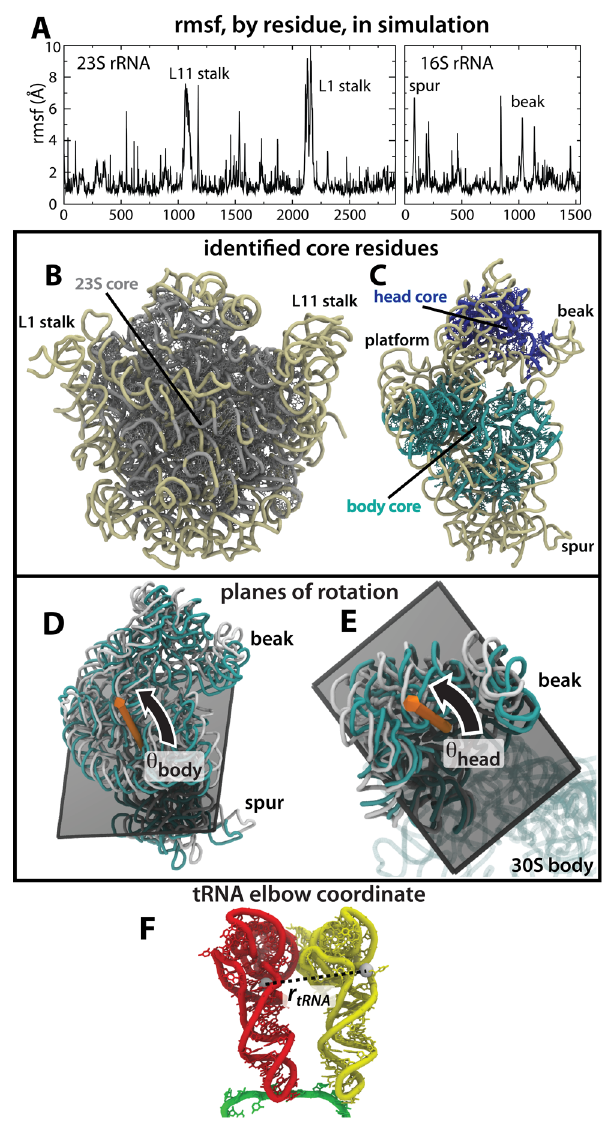
Figure 3. Reaction coordinates for 30S rotation and tRNA movement. A) rmsf, by residue, for the 23S (left) and 16S (right) rRNA. rmsf measures (See Text S1) were used to define the core residues (shown with side chains) of the: B) 23S rRNA (gray) and C) 16S body (cyan) and 16S head (blue). Core residue groups were used to define the planes of rotation for D) body rotation ( h body , positive in the counter-clockwise direction) and E) head swivel ( h head ). The vectors that define the rotation planes are depicted by orange arrows. The angle between the vectors is 31 0 . In (D) and (E), the classical and rotated configurations are shown in cyan and white. tRNA position is measured by r tRNA , as defined previously [49,50] and is shown for F) the classical A/A-P/P tRNA